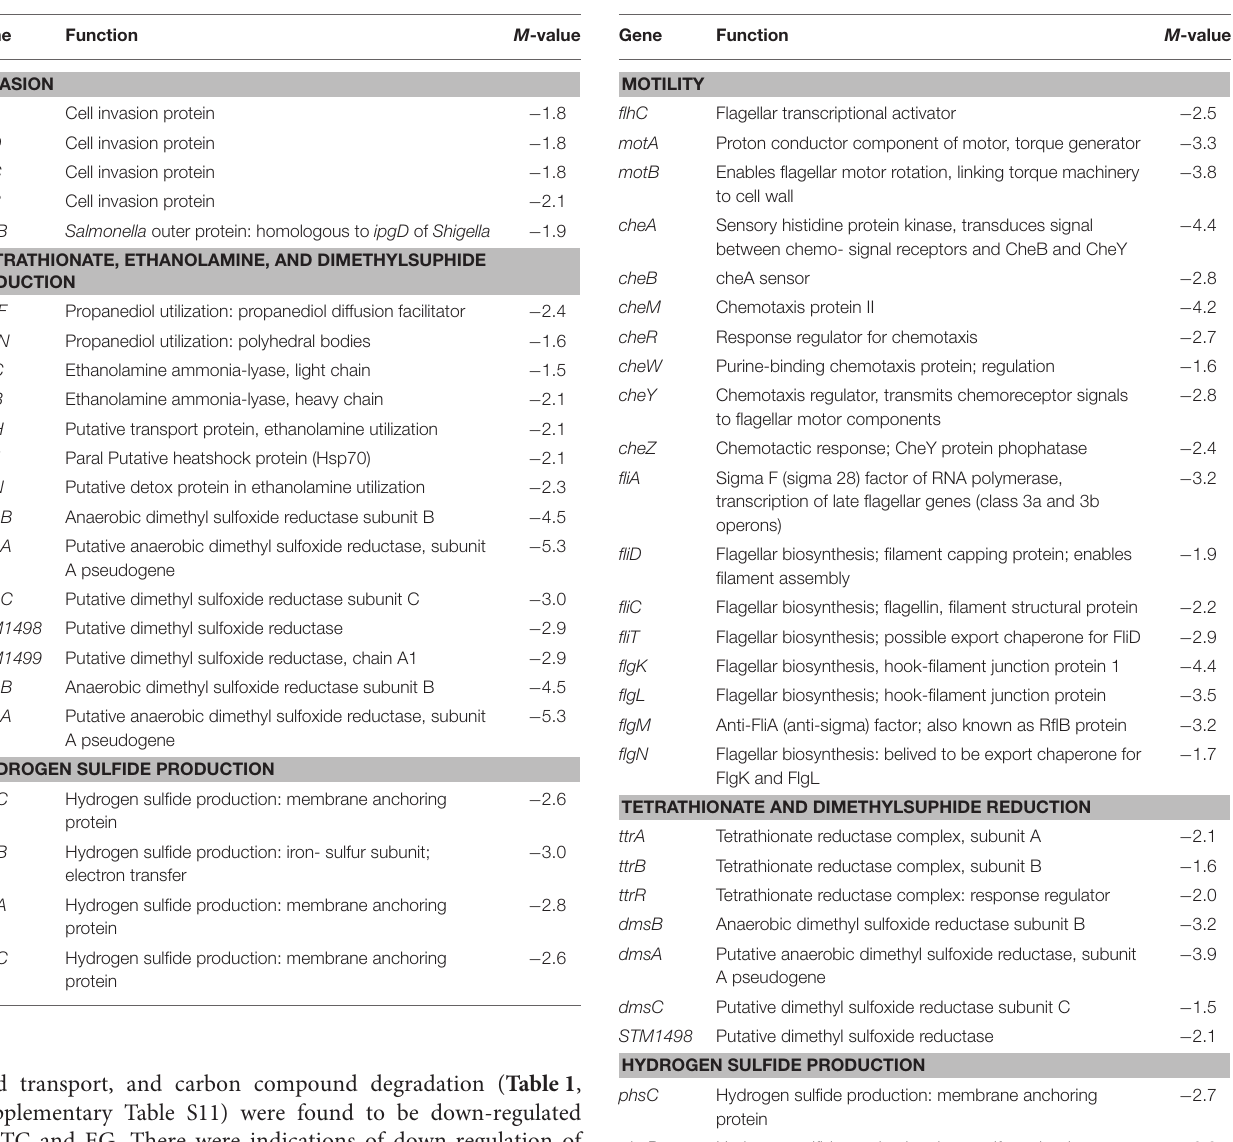
TABLE 3 | Select genes predicted to be differentially regulated in PT8 exposed to SICs of EG, but not TC ( P < 0.005, M ± 1.5), based on the microarray data.